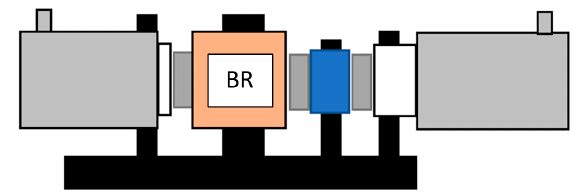
Figure 6. BR connection arrangement in configuration B.